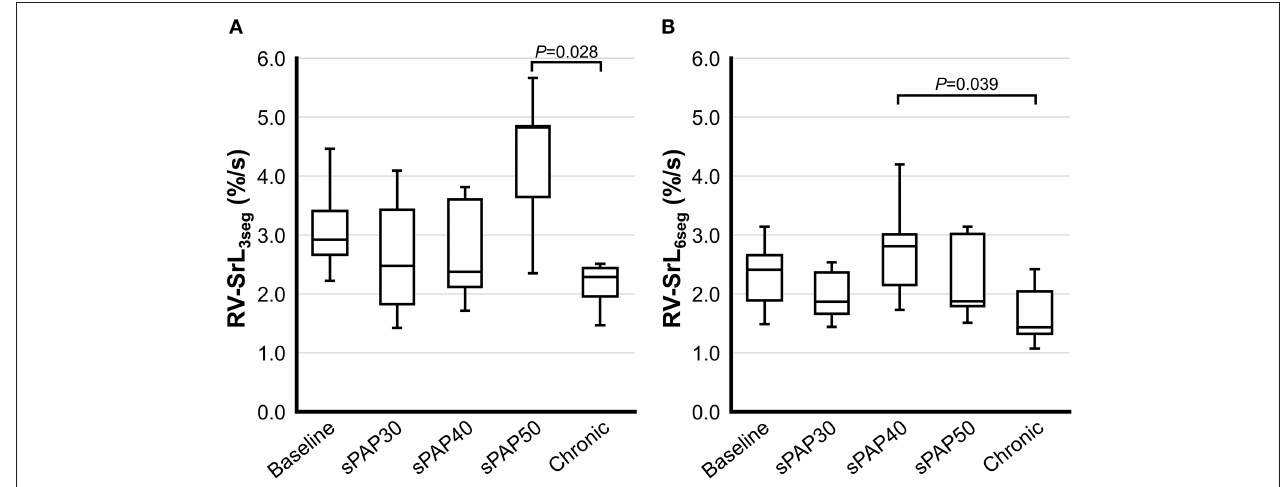
FIGURE 3 | Box and whisker plots of the right ventricular longitudinal strain rate (RV-SrL) obtained from two-dimensional speckle tracking echocardiography. The bottom of the box is 25%, the middle line is the median, the top of the box is 75%, and the whiskers represent the range. (A) RV-SrL of the right ventricular free wall (RV-SrL 3seg ). (B) RV-SrL of the global right ventricle (RV-SrL 6seg ).